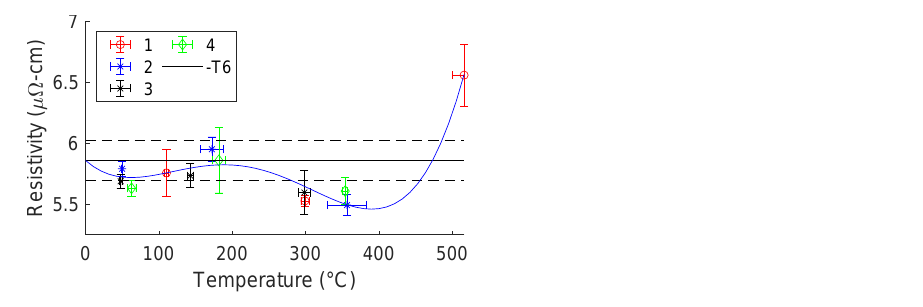
Figure 18. Results of testing using battery bank as power supply; Legend values correspond to parameters listed in Table